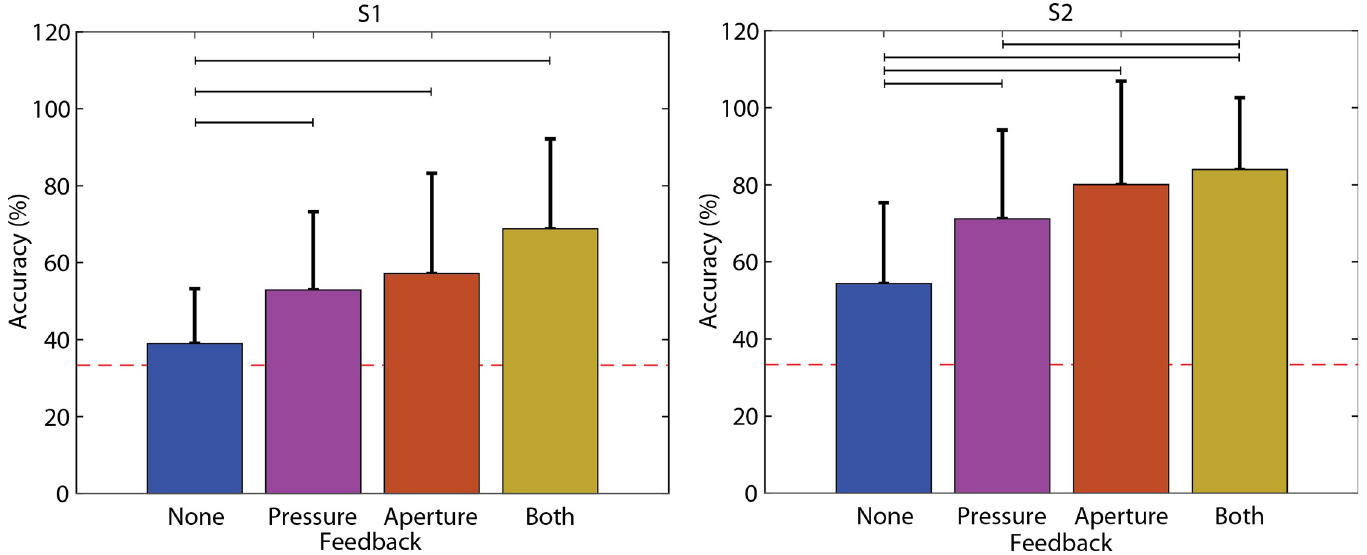
Fig 2. Average and standard deviation of accuracy of foam block identification for both subjects as a function of feedback. The red dashed line is chance (33%). Black horizontal lines denote significant differences (p < 0.05). Accuracy increased with any feedback and was best with both forms of feedback. Averaged across all identification tasks. S1: n = 300 (none), 135 (pressure), 165 (aperture), 150 (both). S2: n = 375 (none), 375 (pressure), 375 (aperture), 330 (both).